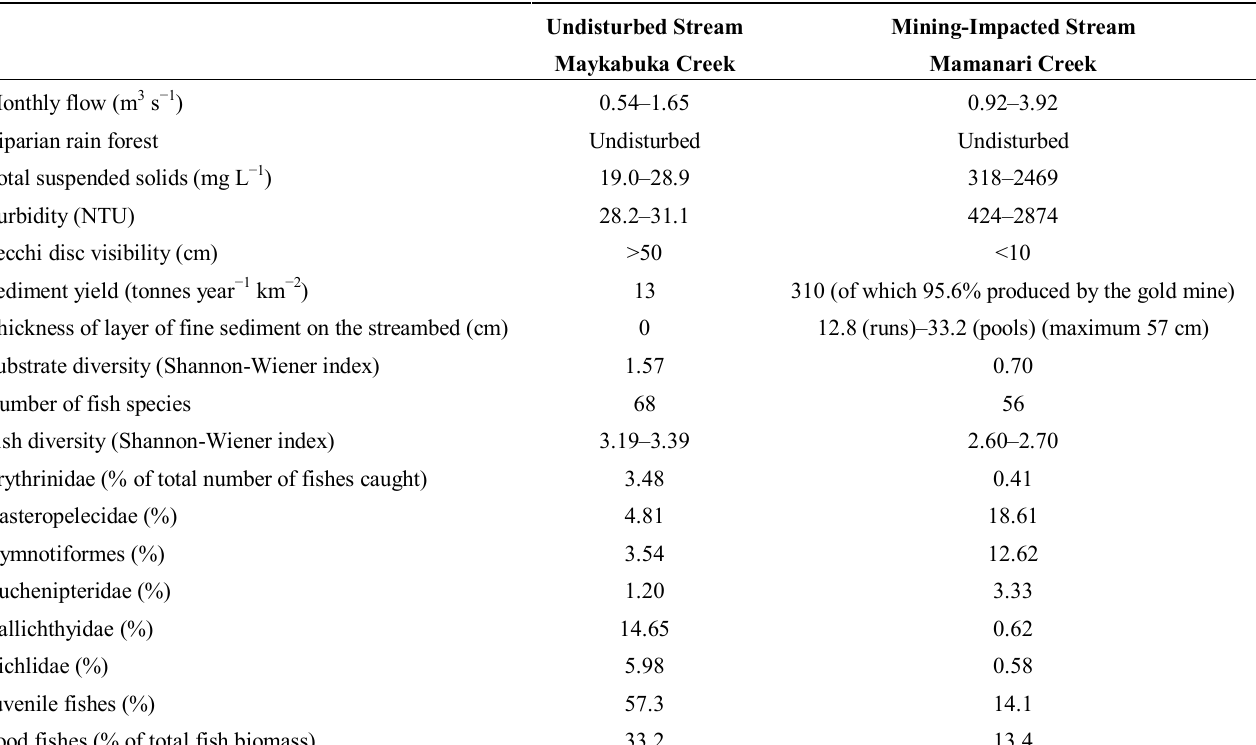
Table 1. Downstream impact of gold-mining related erosion on instream habitat and fish community structure of a small rainforest stream in Suriname in the period 1994–2001, data from Mol and Ouboter [34].